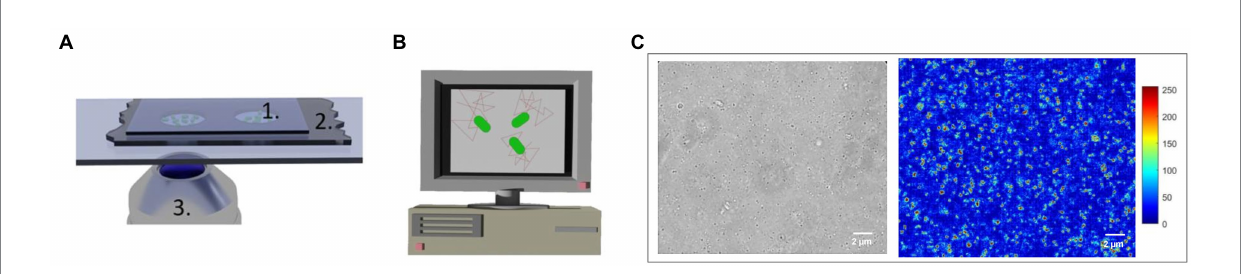
FIGURE 3 Image acquisition set-up (not to scale) (A) 1. Analysis chamber with mitochondria 2. Double-sided 10 μ m thick adhesive foil, 3. Optical microscope objective. (B) Computer screen displaying mitochondrial displacements. (C) Optical and changing pixel typical images of a group of mitochondria undergoing nanomotion. The false colors code for the nanomotion amplitude in arbitrary units (blue: immobile, red: highly motile